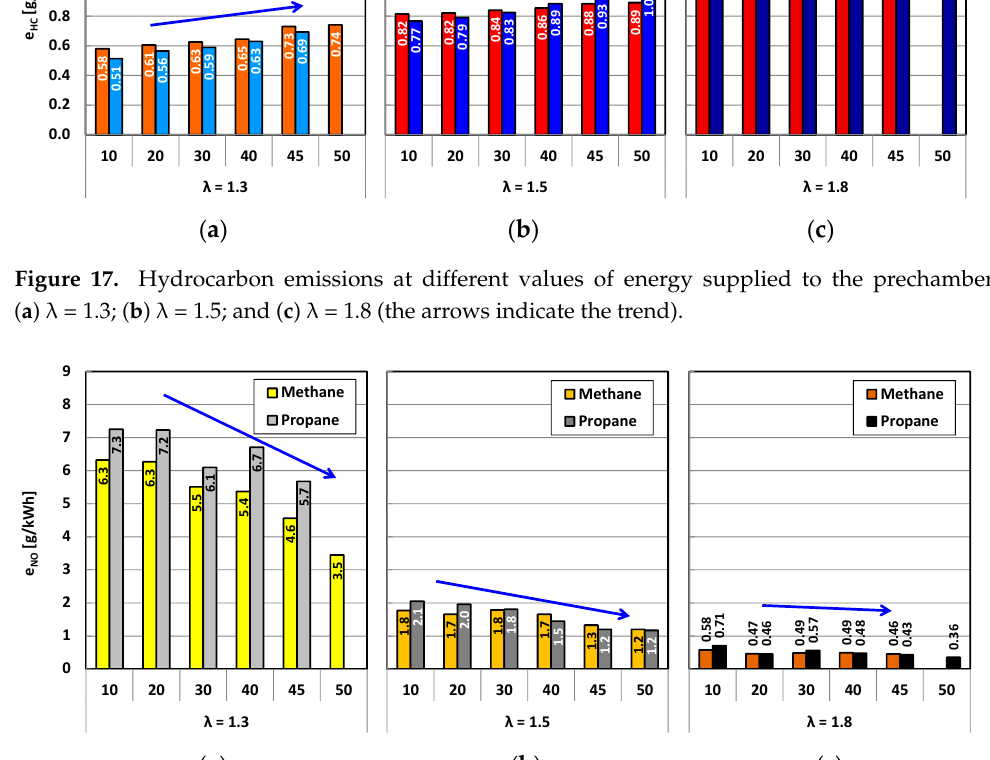
Figure 18. Nitrogen oxide emissions at di ff erent values of energy supplied to the prechamber: ( a ) λ = 1.3; ( b ) λ = 1.5; and ( c ) λ = 1.8 (the arrows indicate the trend).